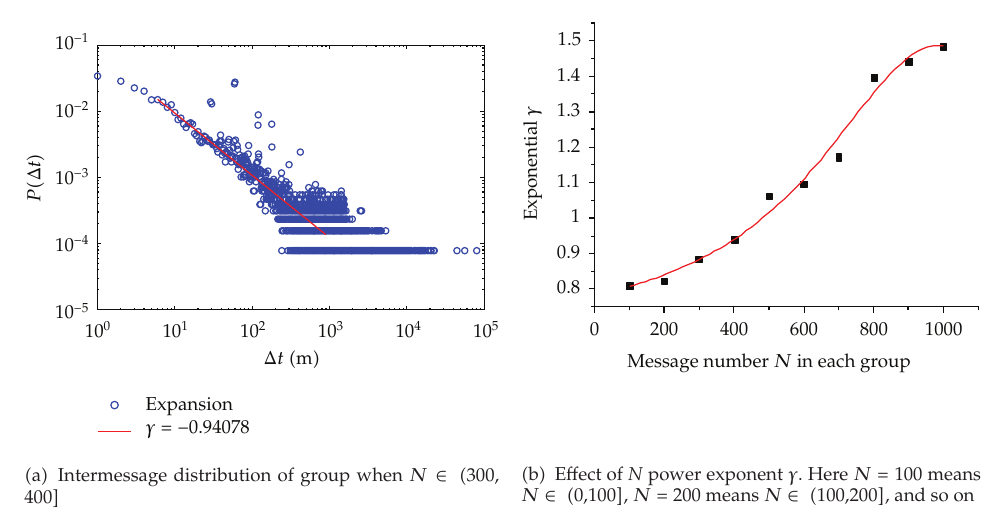
Figure 2: User behavior analysis at group